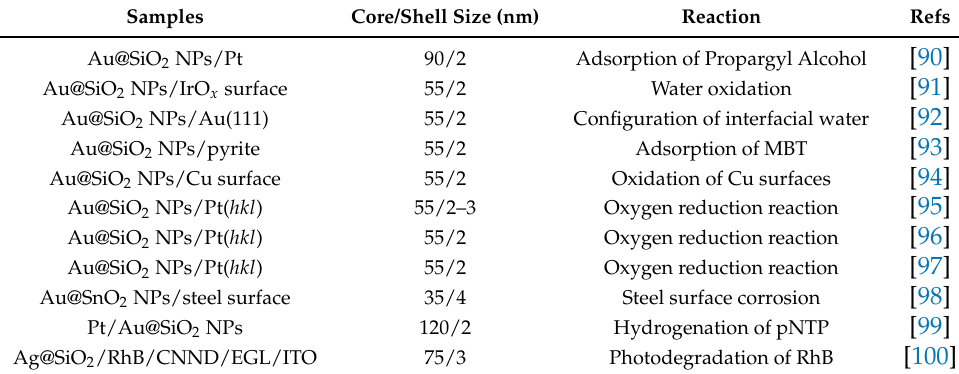
Table 2. SHINERS application to other surface catalytic reactions (NPs = nanoparticles; IrO x = Iridium oxide; MBT = 2-mercaptobenzothiazole; SnO 2 = Tin oxide; pNTP = para-nitrothiophenol; RhB = Rhodamine B; CNNDs = g-C 3 N 4 nanodots; EGLs = Electrochemical exfoliated graphene layers; ITO = Indium tin